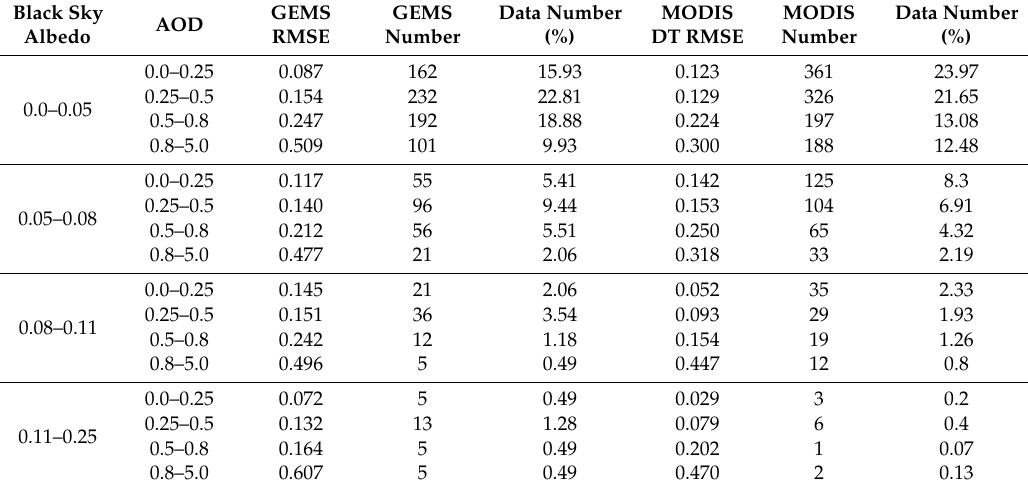
Table 5. Calculated root mean square error (RMSE) of GEMS AOD simulated with OMI L1B data and MODISdarktarget(DT)AOD.GEMSnumberandMODISnumberindicatethetotalnumberofvalidation points, respectively. Data number (%) indicates the (GEMS number / Total GEMS number) × 100 and (MODIS number / Total MODIS number) × 100,